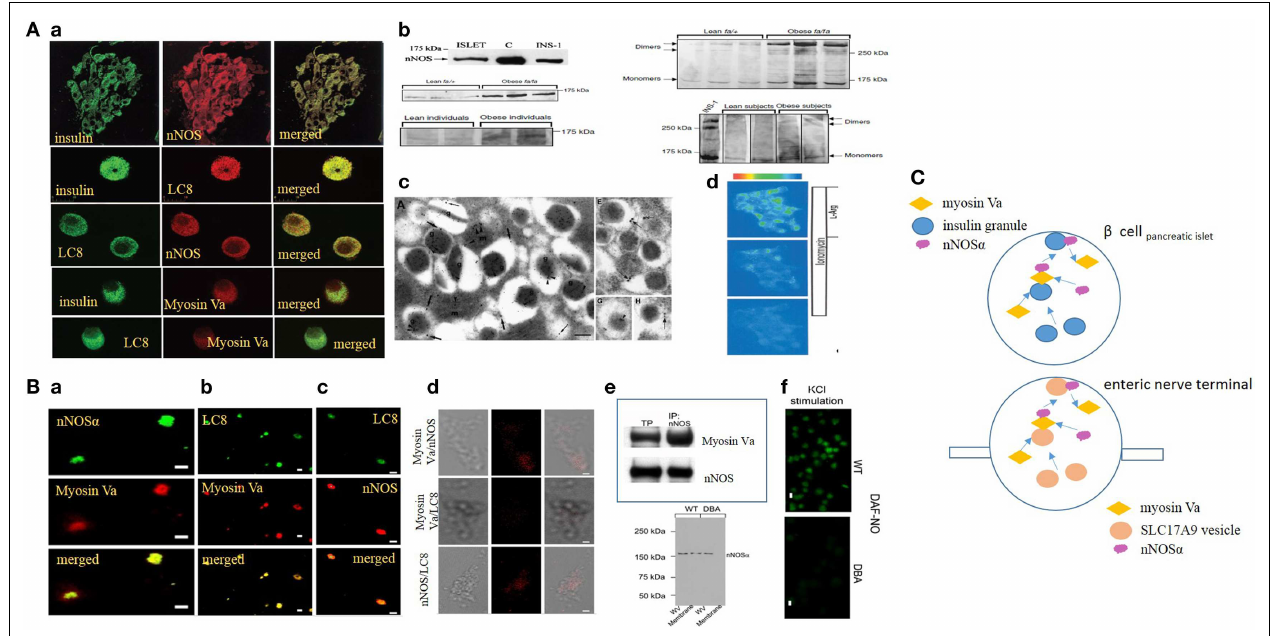
synaptosomes. (d) Proximity ligation assay (PLA) shows blobs of protein interactions of nNOS, LC8, and myosinVa in isolated enteric synaptosomes. (e) Upper panel shows co-immunoprecipitation of nNOS-myosinVa in mice stomach lysate; lower panel shows intact nNOS α in whole varicosities of